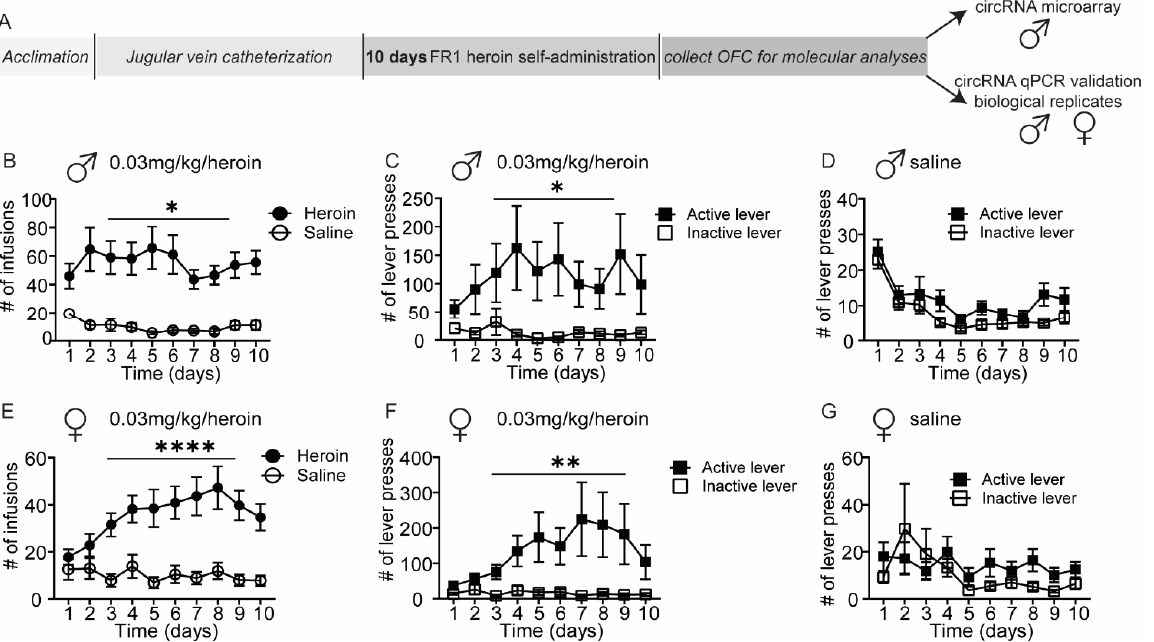
Figure 1. Heroin self-administration as a tool to identify heroin-responsive circRNAs in the OFC. ( A ) Schematic overview of experimental timeline. Male and female rats underwent self-administration of 0.03mg/kg/infusion of heroin or saline and were then euthanized for molecular analyses of circRNA expression in the OFC. OFC RNA from a subset of male rats was used for circRNA microarray analyses. Differentially regulated circRNAs were validated in all male rats and further examined in female rats. ( B – G ) Heroin and saline self-administration in male ( B – D ) and female ( E – G ) rats. Displayed are the number of infusions ( B , E ) and active or inactive lever presses for heroin ( C , F ) or saline animals ( D , G ). Error ± S.E.M. * p < 0.05; ** p < 0.01; **** p < 0.0001. Male N = 21/group; Female N = 14 saline, 13